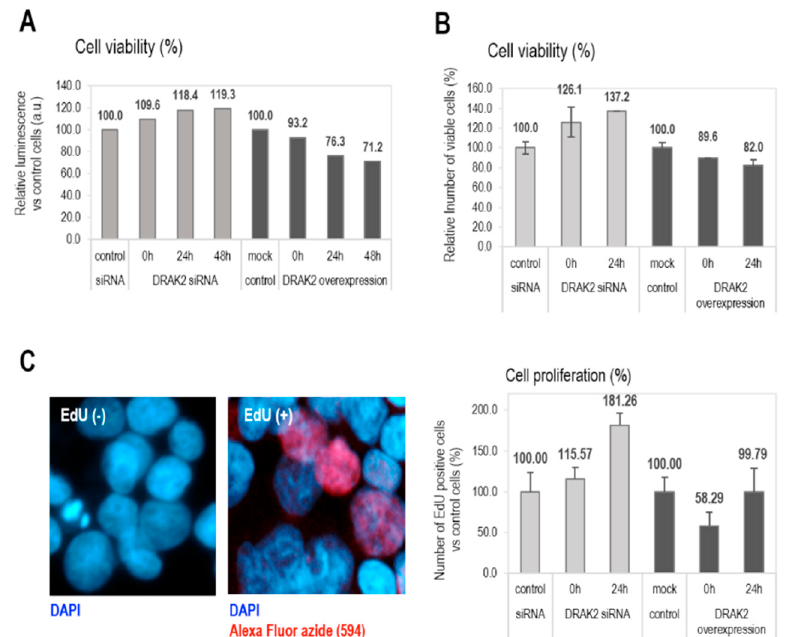
Figure 4. DRAK2 impact on the cellular viability ( A , B ) and proliferation ( C ). Cellular viability was measured using the CellTiter-Glo ® Luminescent Cell Viability Assay ( A ), trypan blue staining ( B ), and the cell proliferation endpoint was evaluated by cell counting following EdU (5ethynyl-2 ′ -deoxiuridine) ( C ). All experiments were repeated 3 times, and error bars represent the standard error of the mean of 5 experiments.